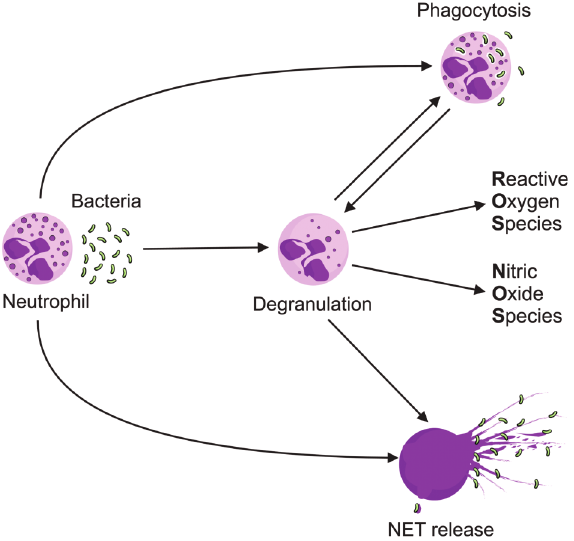
Figure 1. Mechanisms used by neutrophils to control infection. Phagocytosis is a primary mechanism of pathogen elimination. Upon activation, usually through recognition by toll-like receptors (TLRs), neutrophils can degranulate, releasing their granule content. Neutrophils can also release nuclear contents along with the granule contents, ‘‘ trapping ’’ and killing the microorganism through neutrophil extracellular traps